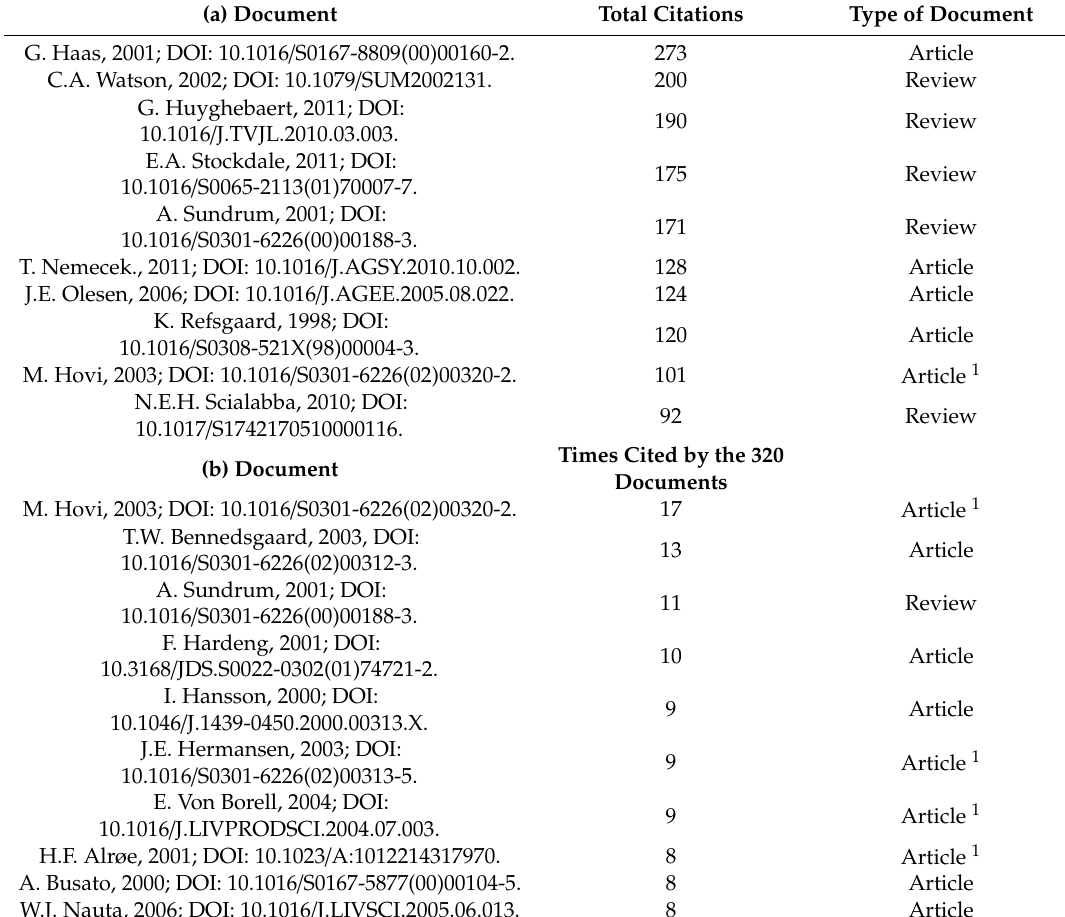
Table 1. ( a ) The 10 most cited papers among the 320 selected documents on organic livestock farming. First author name, year of publication, digital object identifier (DOI), total citations, and type